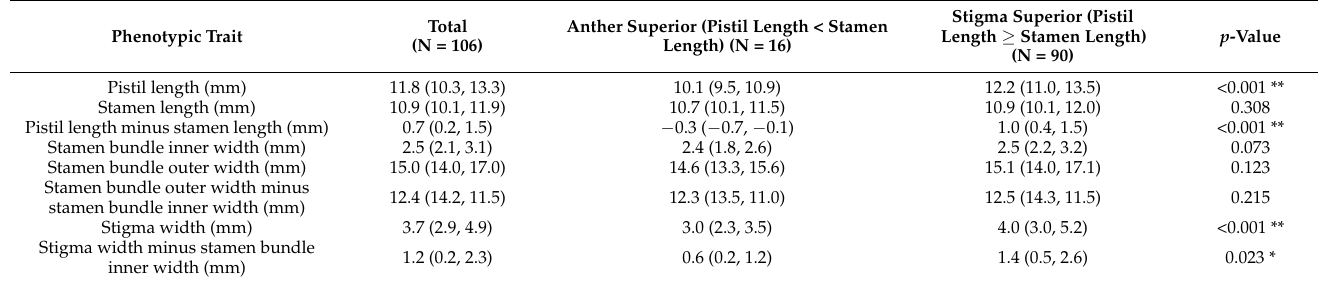
Table 2. Comparison of phenotypic traits between the anther and stigma superior groups.